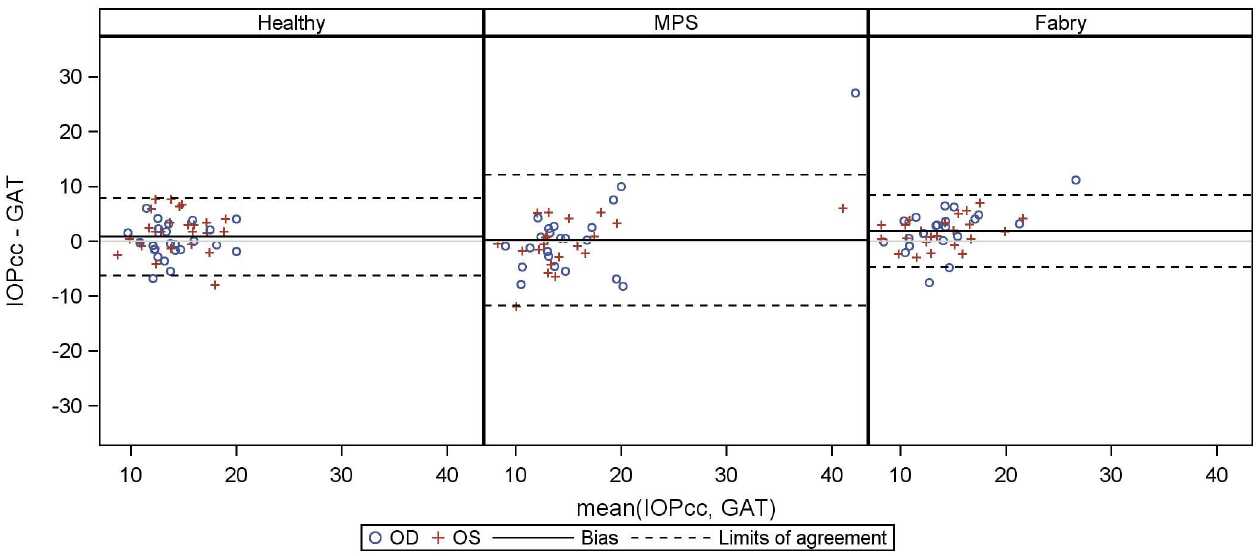
Fig 6. Bland-Altmann Plot for agreementbetween Goldmann applanation tonometry (GAT) and corneal-compensated IOP (IOPcc).